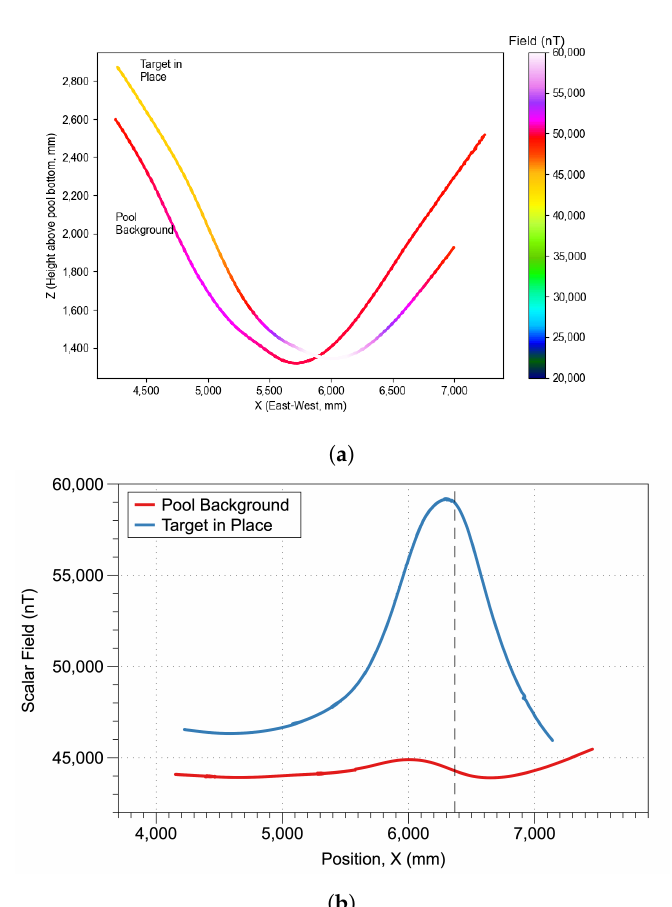
Figure 6. Comparison of glider flight tracks before and after target seeding in the testing environment. Localized changes in magnetic scalar field along East-West glider tracks (X-axis) shows the viability of target detection with the underwater glider platform ( a ) Two glider tracks within 0.5 meters y from the background and experimental tracks. Traces are colored according to scalar total field. ( b ) Scalar field magnitude before and after target